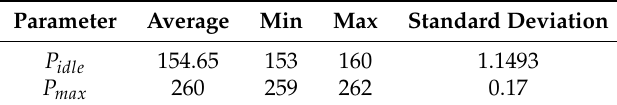
Table 1. Measured values of P idle and P max .